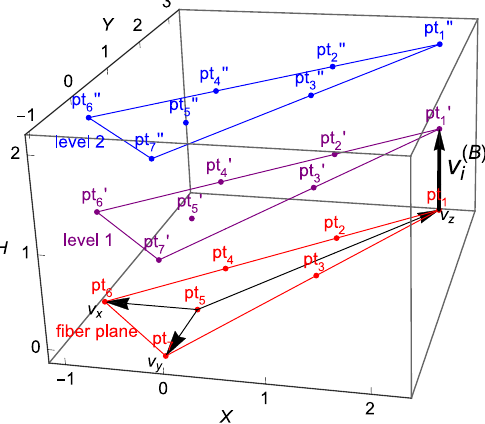
Figure 2. A 3D visualization of the lattice points that appear in a top over v ( B ) P 2 ; 3 ; 1 models, a top over a ray in the base v ( B )